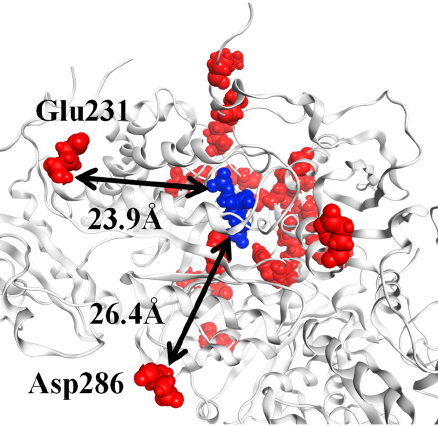
Figure 8. Location of the top 20 residues in the second left-singular vector. For the L 2 dimer of RuBisCO (PDB ID: 1UWA, FMODB ID: 53J5Z), the 2CABP ligand is shown by blue spheres, and red spheres represent the residues corresponding to the top 20 sites for the second left-singular vector (A-chain: Glu231, Asp286, His298, Asp302, Arg303, His327, Lys356, Arg360, His386, Ile465, and Glu468; O-chain: Lys14, Gln45, Ala56, Thr68, Glu110, Lys128, Ala129, Arg131, and His307). The distance between 2CABP and Glu231 is 23.9 Å, and that between 2CABP and Asp286 is 26.4 Å.